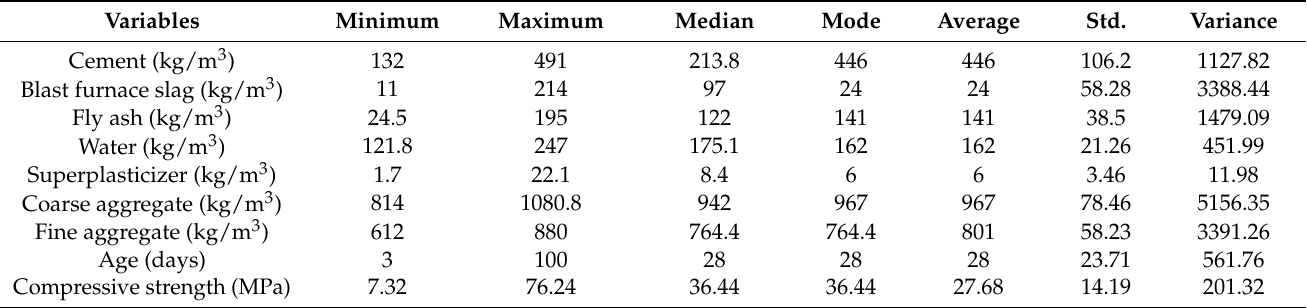
Table 1. Variable data